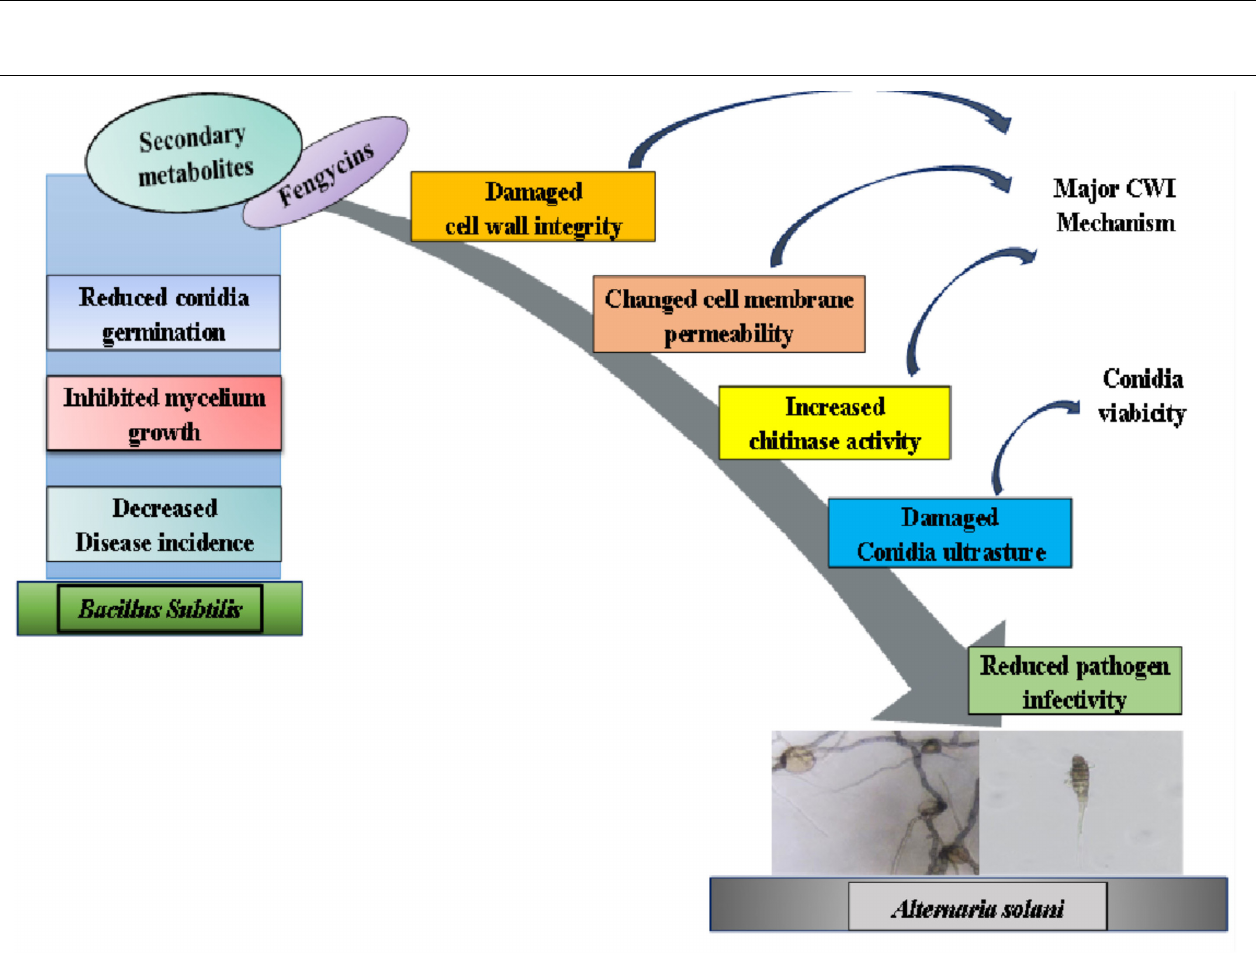
Frontiers in Microbiology |